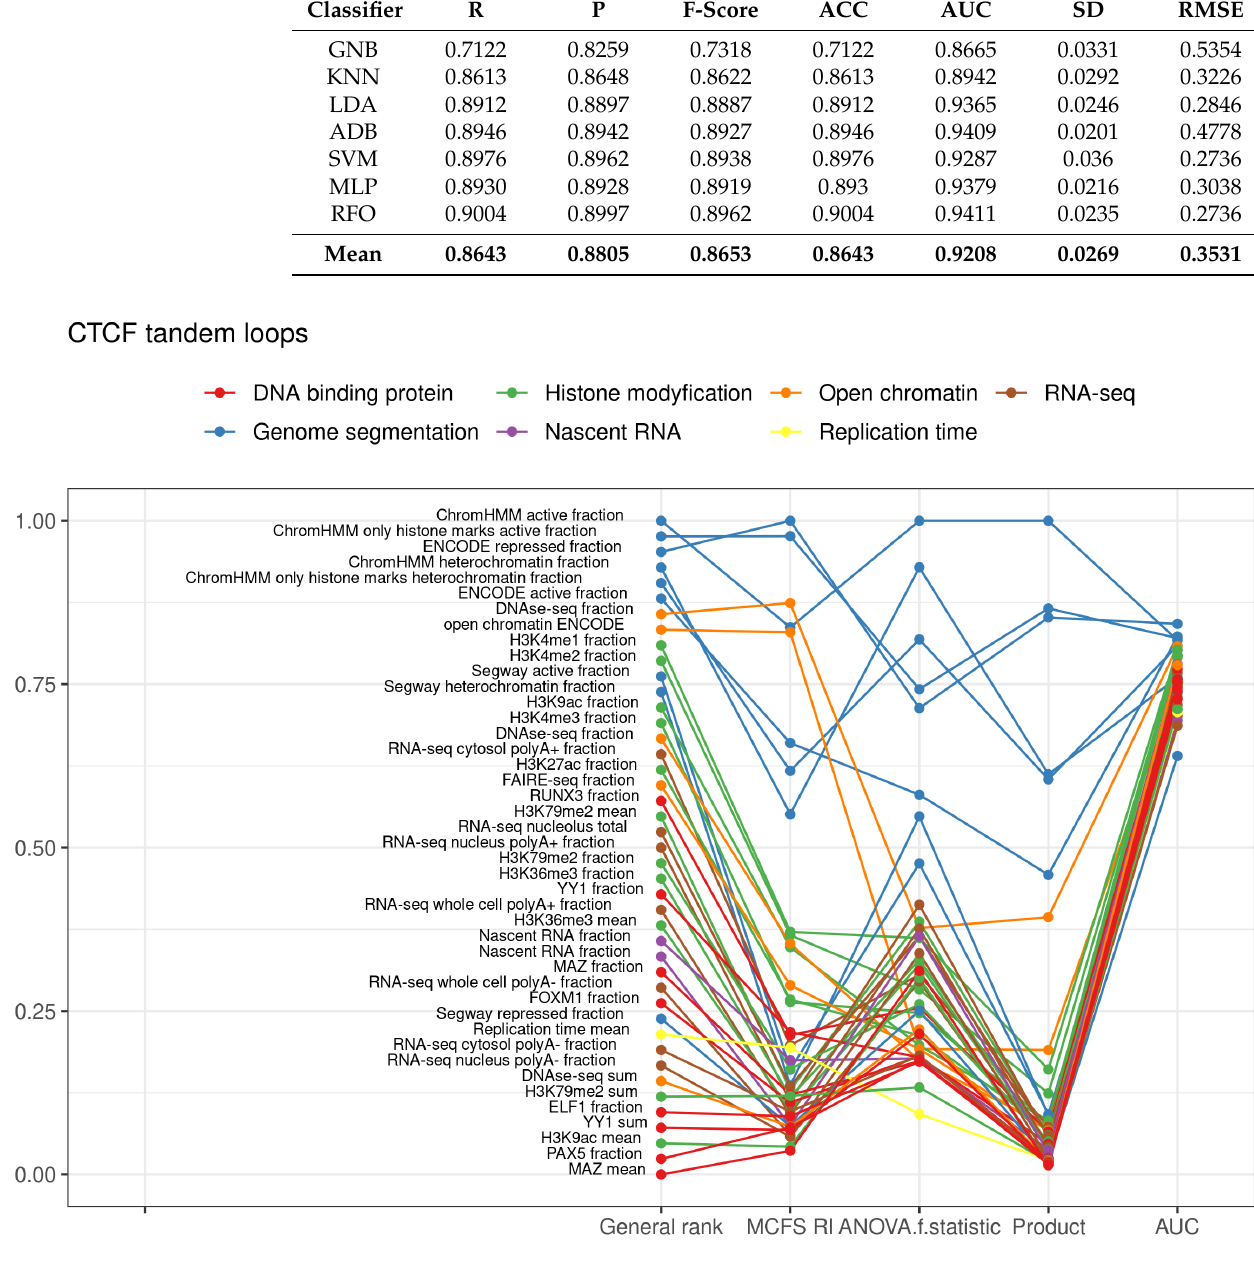
Table 3. Compartment prediction performance using various genomic marks of CTCF tandem loops for various classifiers (all 428 features are considered for classification).